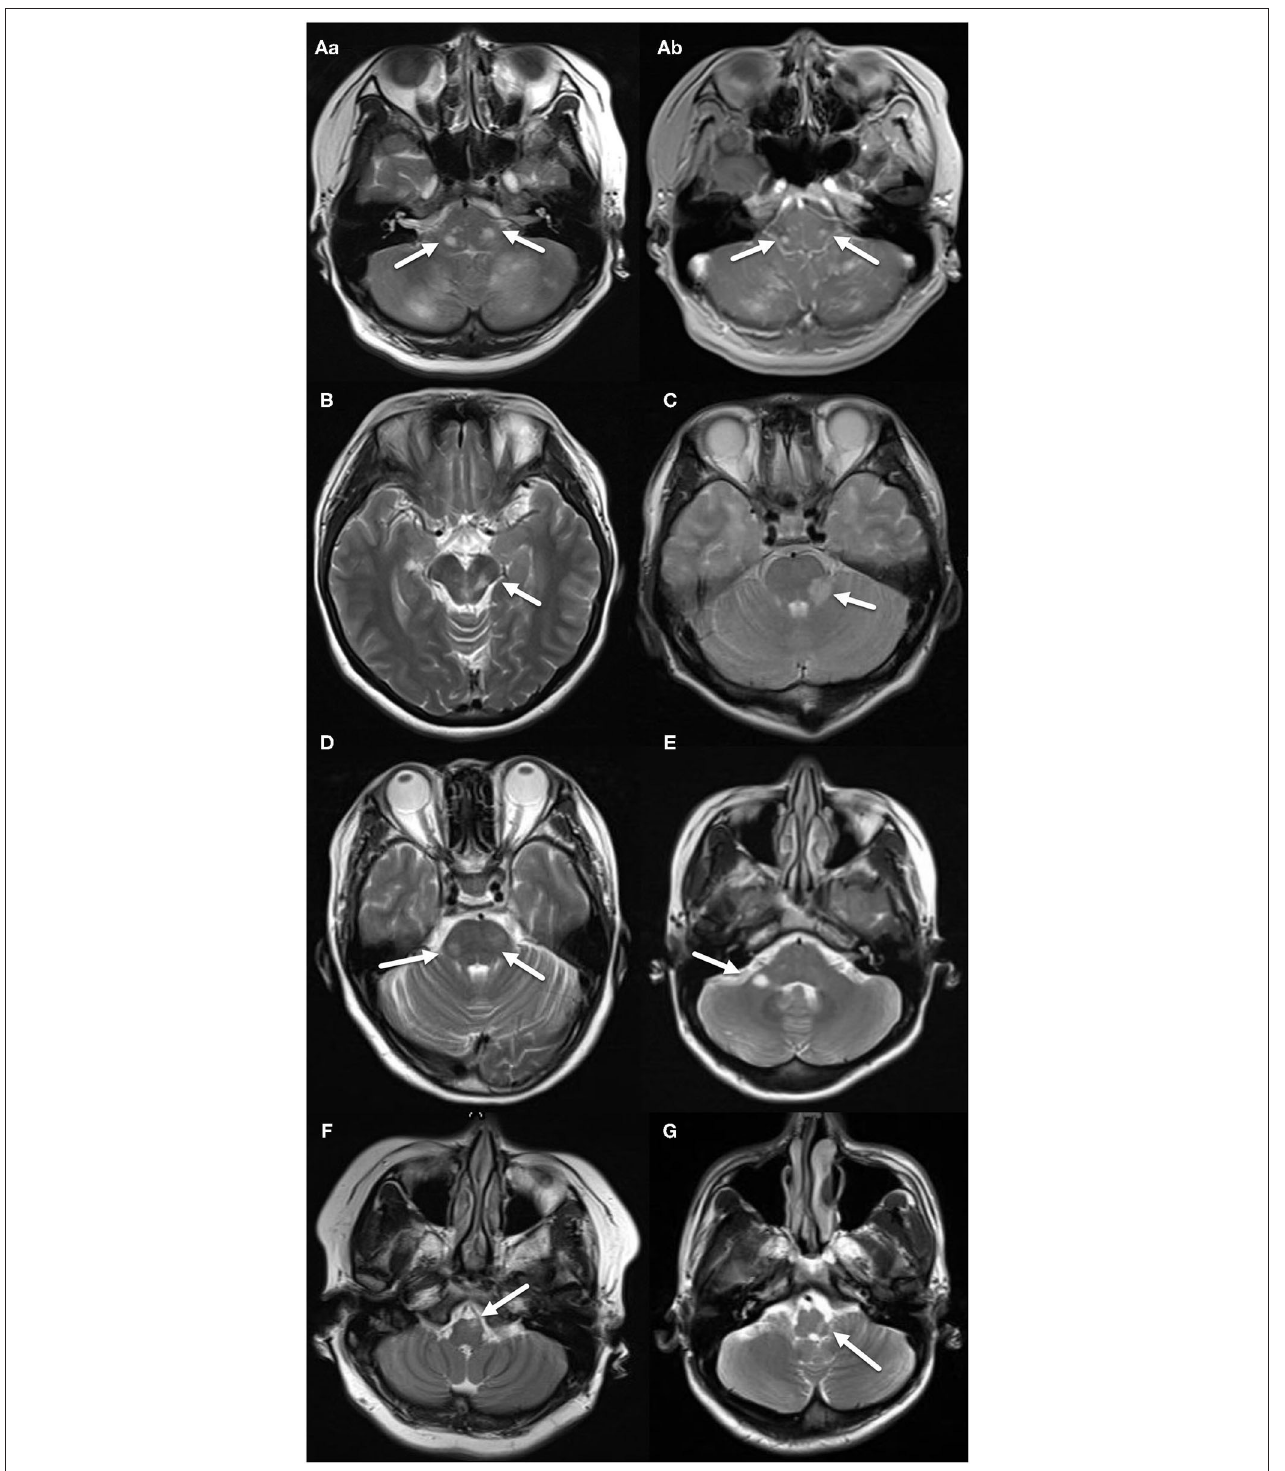
FIGURE 1 | MRI features of the MS group. ( A –a) Two patchy, abnormal signals located on both sides of pons, indicated by arrows. ( A –b) Two nodular enhancing lesions located on both sides of pons, indicated by arrows. (B) Patchy, abnormal signal located in tegmentum of midbrain, indicated by an arrow. (C) Patchy, abnormal signal located in left brachium pontis, indicated by an arrow. (D) Two patchy, abnormal signals located on both sides of pons, indicated by arrows. (E) Ovoid, abnormal signal located in right brachium pontis, indicated by an arrow. (F) Patchy abnormal signal located in left ventral medulla oblongata, indicated by an arrow. (G) Patchy abnormal signal located in left dorsal medulla oblongata, indicated by an arrow.